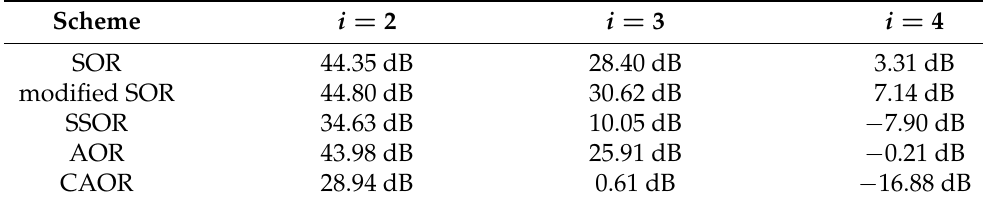
Table 4. Comparison of the degree to which the BER performance approaches that of conven- tional MMSE among all detectors in terms of dB value under different iteration numbers when N R × N T = 128 × 16 and SNR is 45 dB.